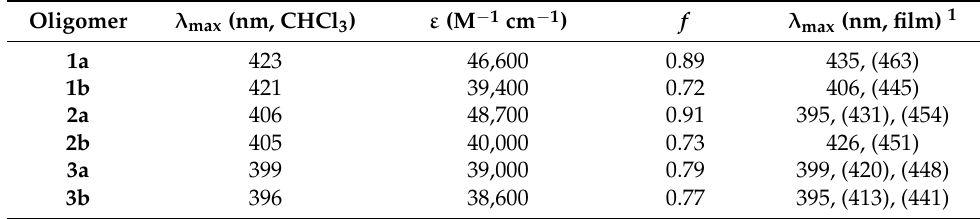
Table 4. Photophysical data for N -octyl- and N -phenyl-2,6-diarylpyrrolo[2,3- d :5,4- d (cid:48) ]bisthiazoles.